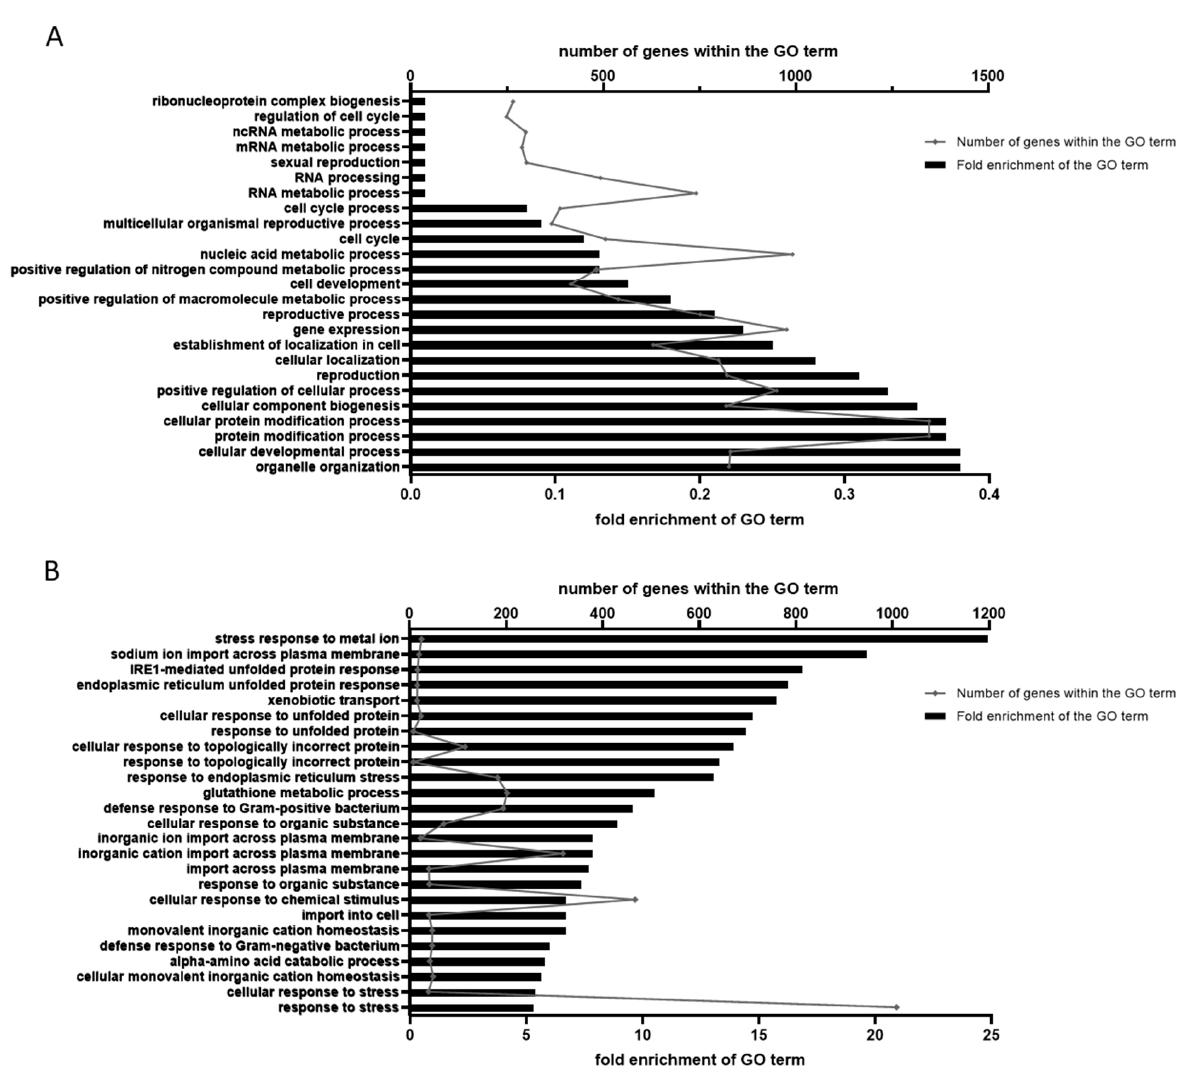
Figure 5. GO annotation of DEGs identified at 180 min 100 mM MnCl 2 vs. 0 min 100 mM MnCl 2 . ( A ) GO terms of genes with decreased and ( B ) increased expression levels in the 180 min samples compared to the control. Fold enrichment shows to what extent the number of detected genes of a specific GO term differentiated from the expected number of genes.